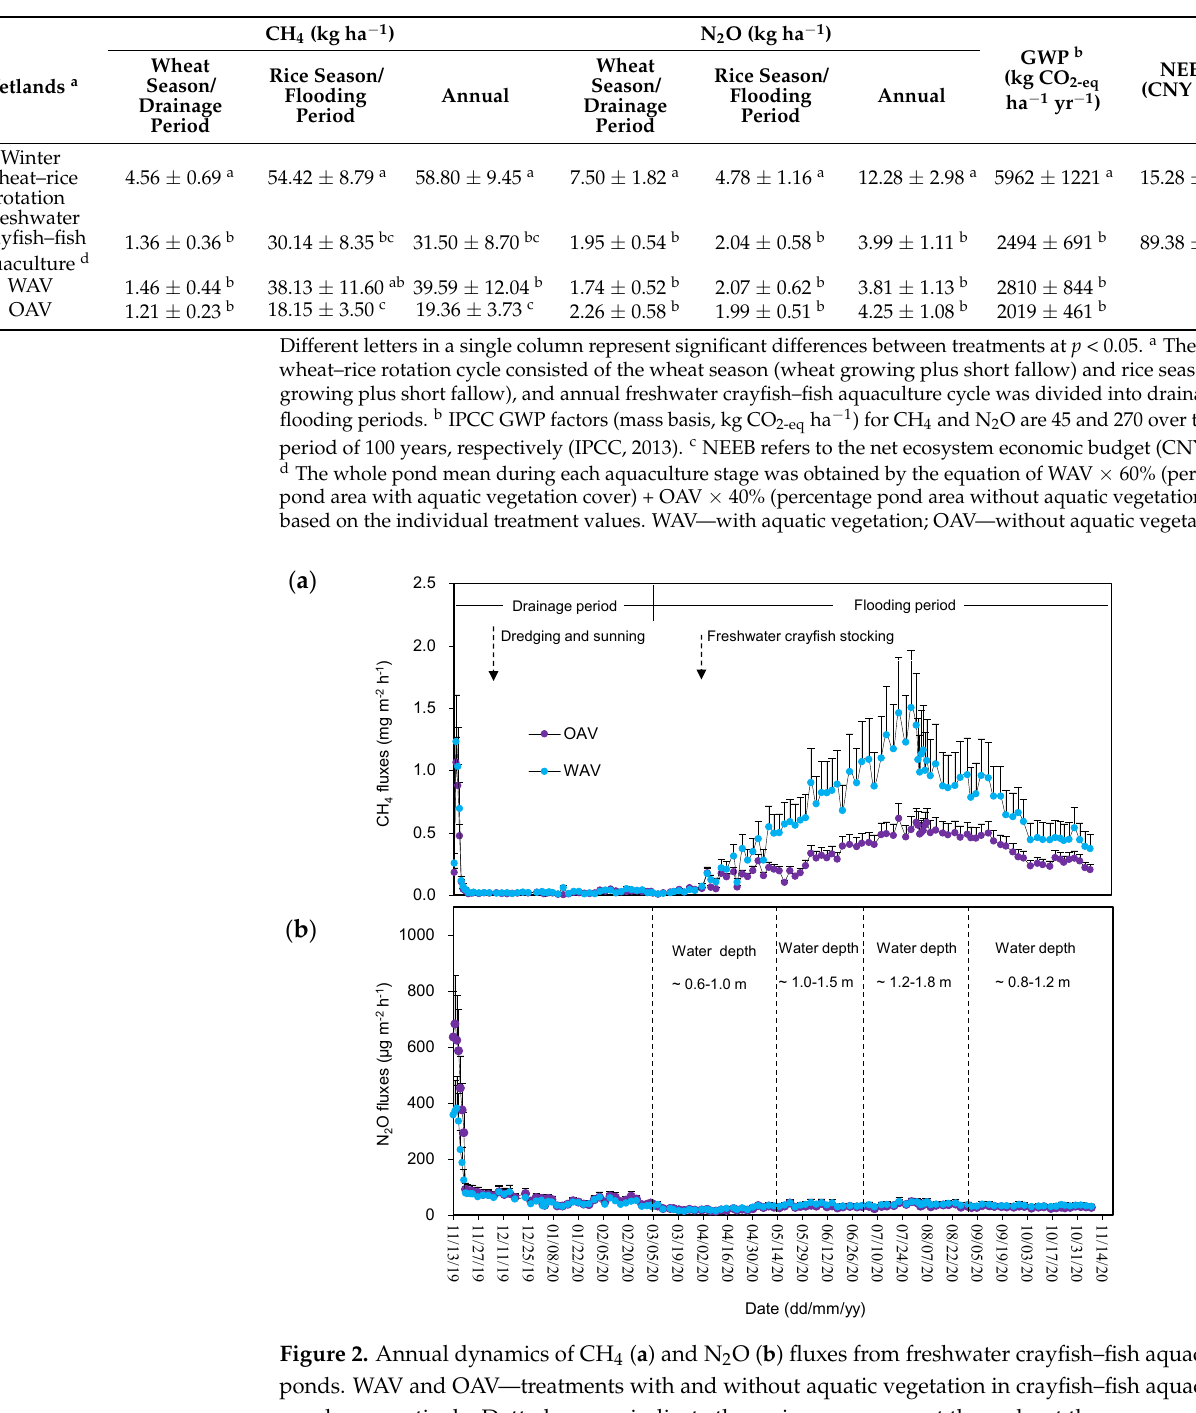
Table 3. Seasonal and annual total CH 4 and N 2 O emissions and their net GWP and NEEB.